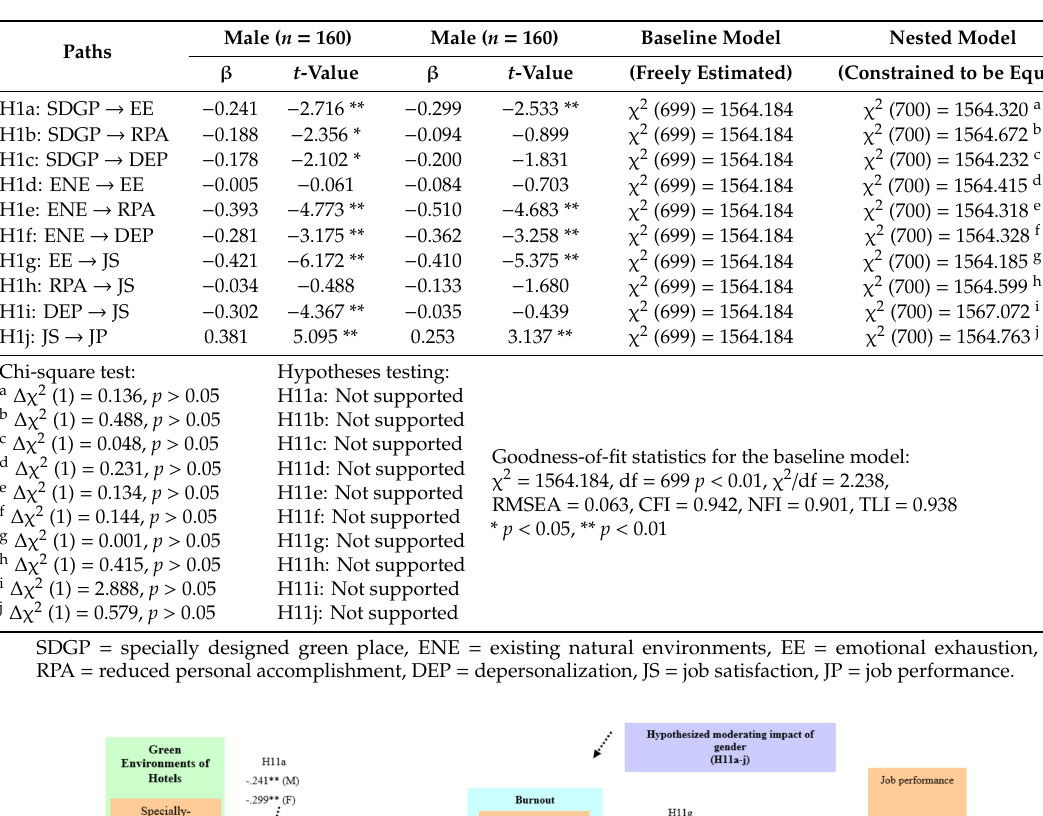
Table 3. Results of the invariance tests for structural models ( n = 309).